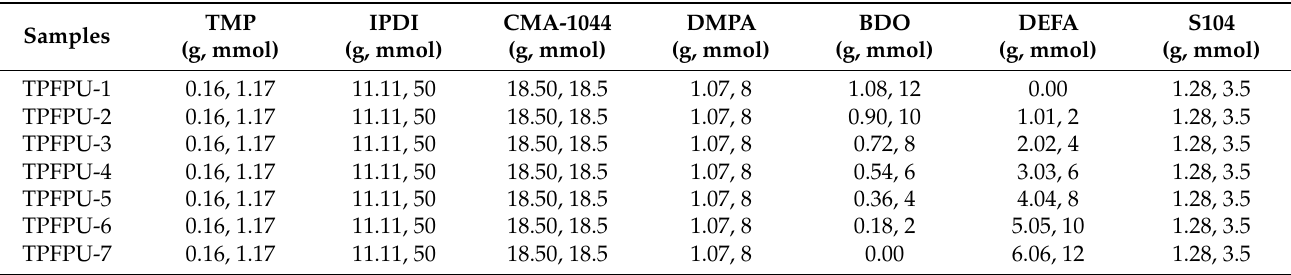
Table 1. The preparation formula for the